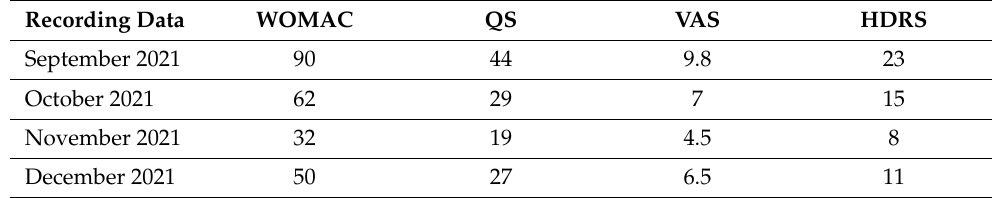
Table 3. Pain assessment and quality of